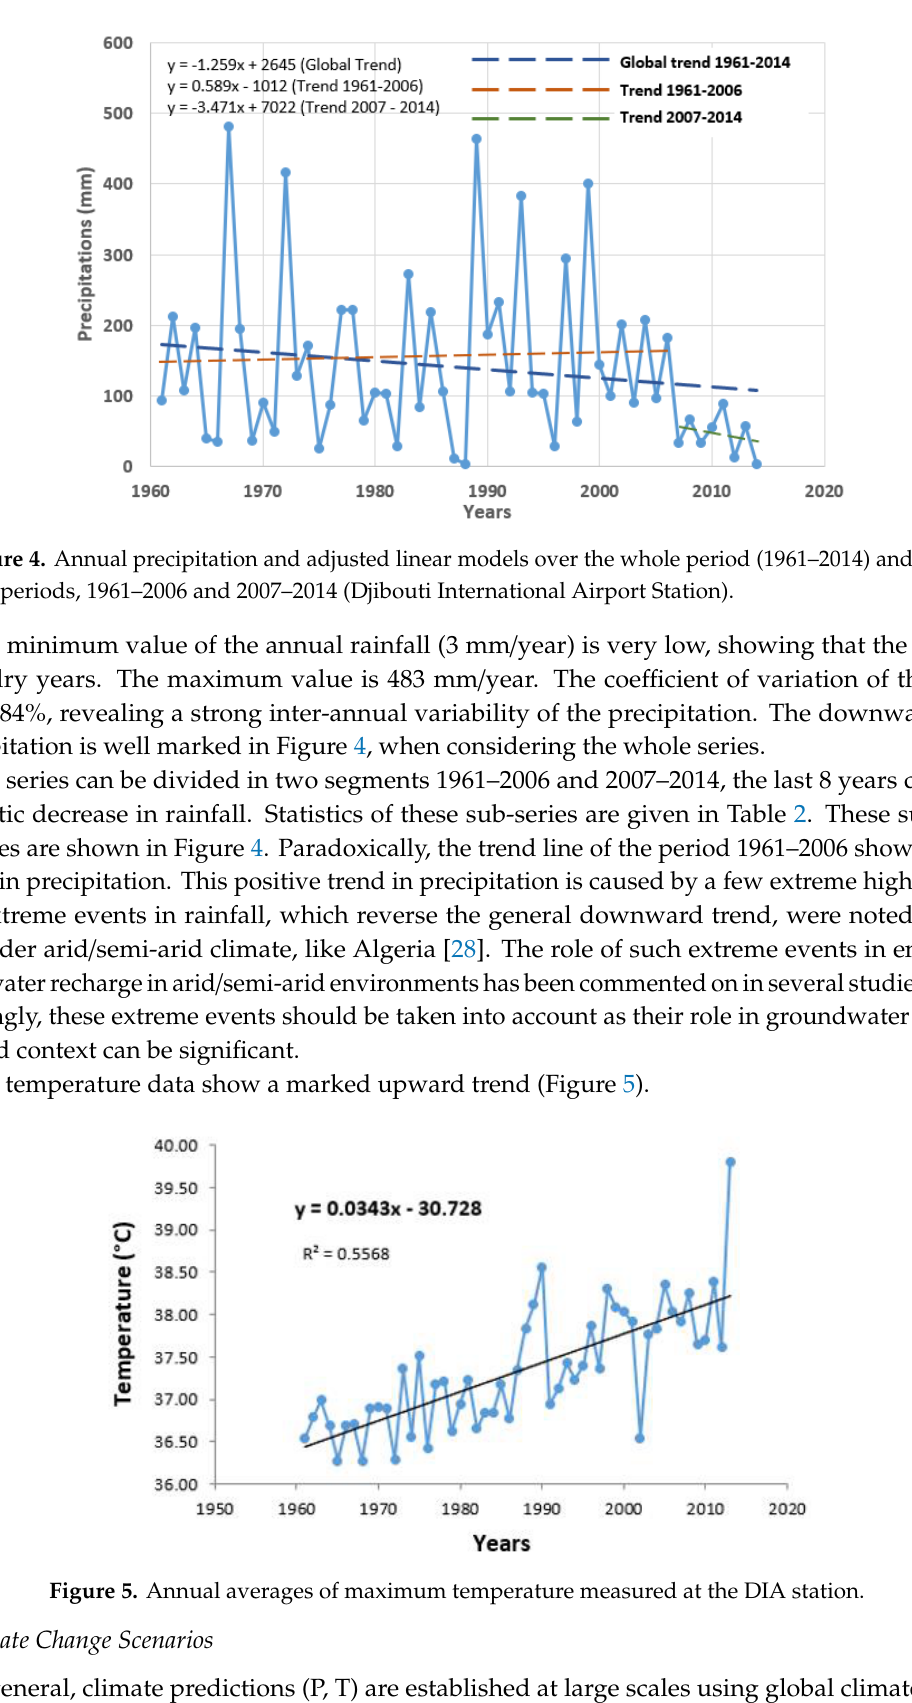
Figure 5. Annual averages of maximum temperature measured at the DIA station.